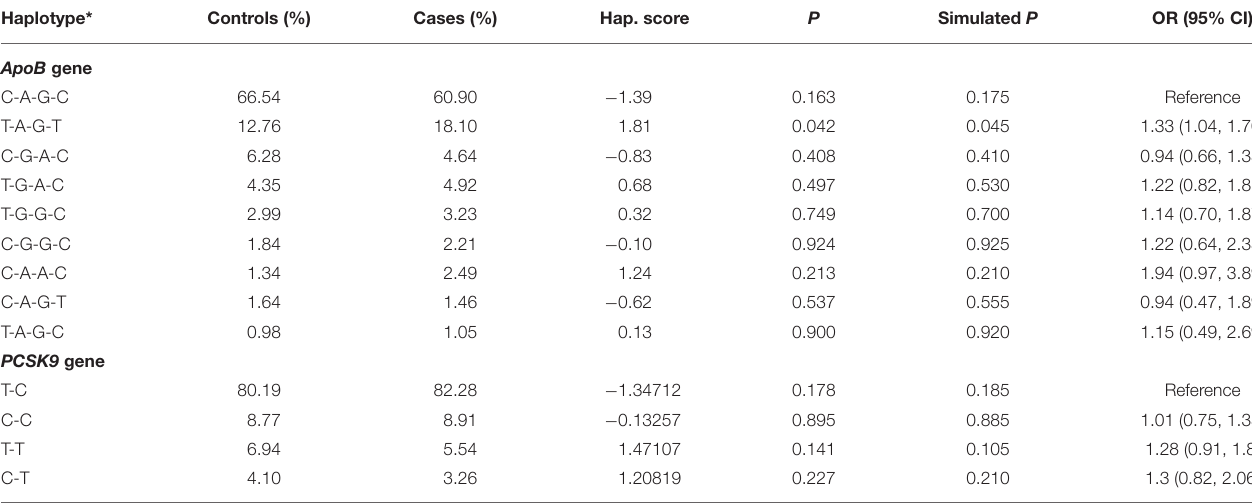
TABLE 4 | The frequency of derived haplotypes between controls and cases, and their risk prediction for diabetic kidney disease.